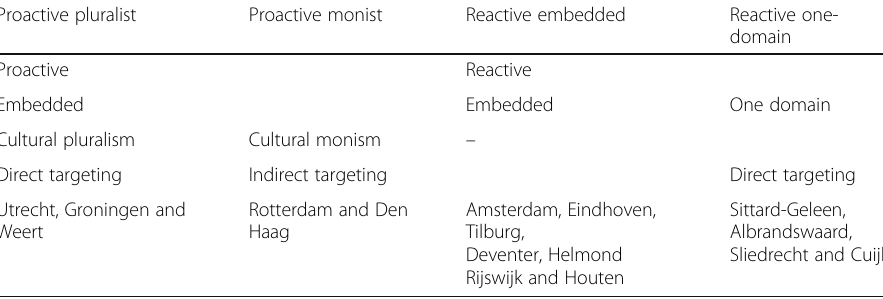
Table 3 City types Proactive